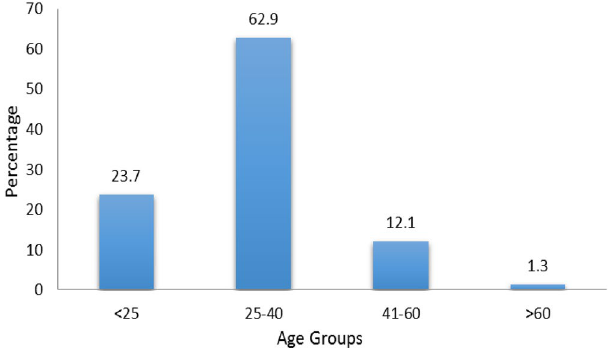
Figure 2. Percentage of age wise responses. The bar chart represents percentages of respondents belonging to different age